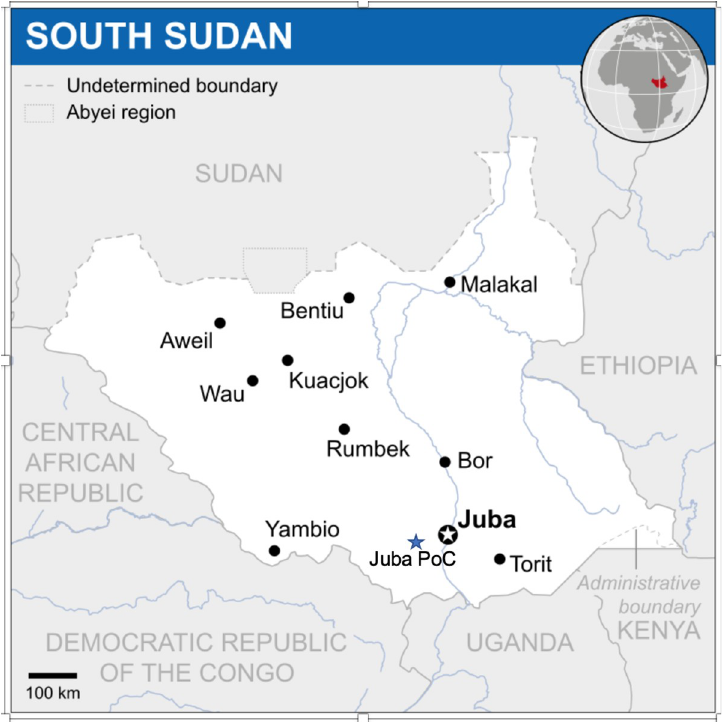
Fig 1. Map of South Sudan with major cities and juba protection of citizens site. Adapted from https://commons. wikimedia.org/w/index.php?curid=32650063.